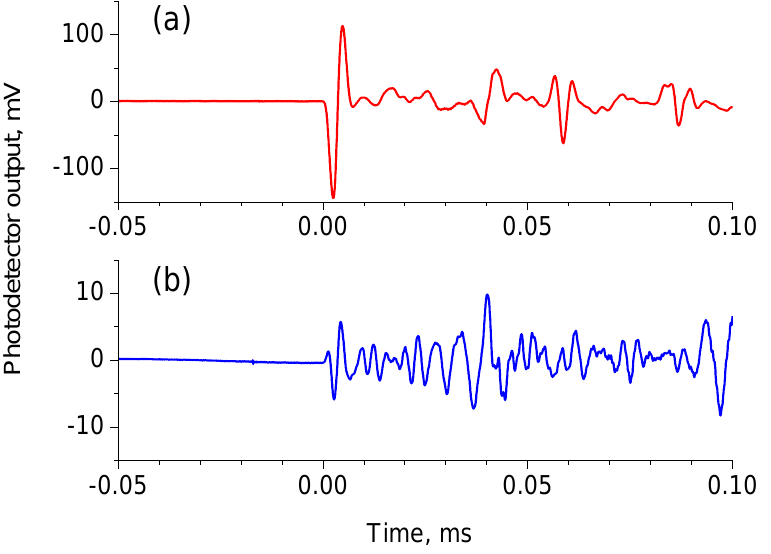
Figure 2. 512-time-averaged FBG sensor response to Lamb waves: (a) Response to S waves, (b) Response to A 0